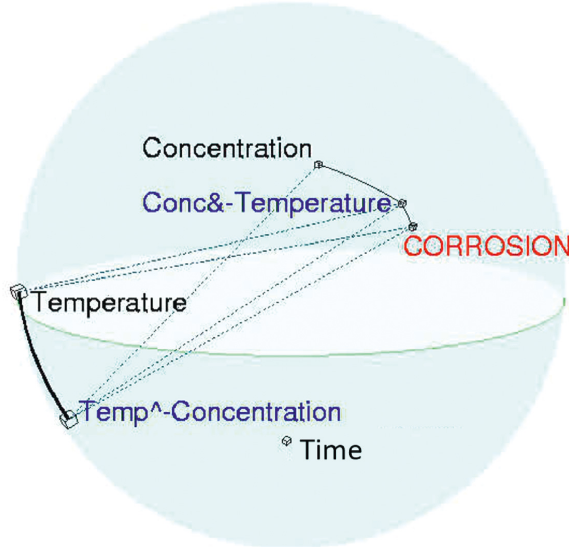
Figure 1: CORICO software: global data